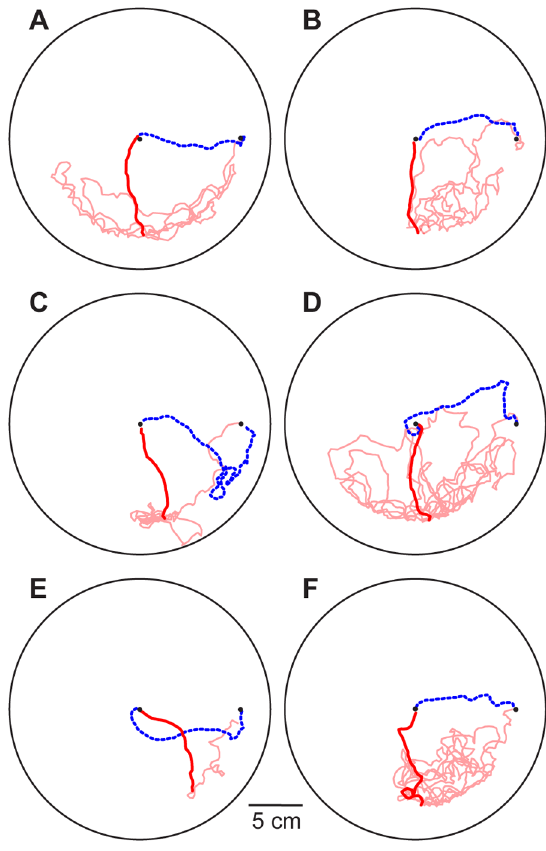
Figure 8. Sample paths before and after rotation of visual cues. Each panel shows a single ant’s paths before rotation (dashed blue line) and afterwards (solid line). Paths after rotation are shown in red until they reach the edge of the acetate circle carpeting the arena, and in pink afterwards. Large circles show arena boundary. Small closed circles show locations of old nest entrance at arena center and new nest entrance at right side.